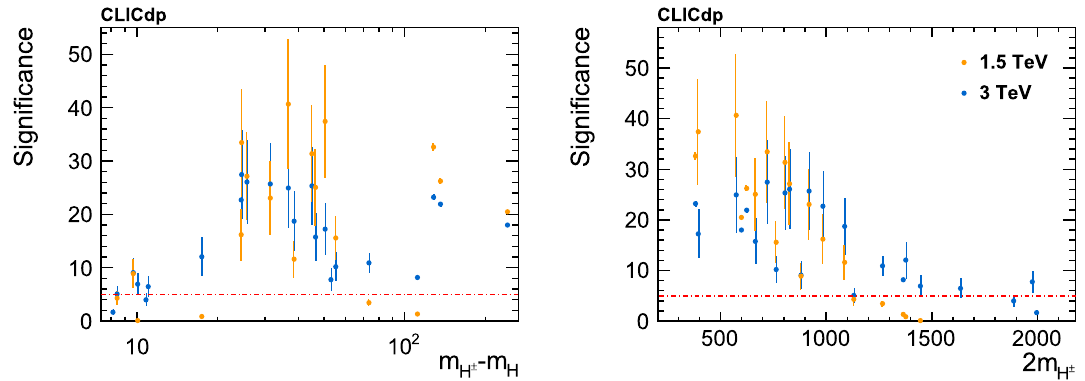
Fig. 7 Expected statistical significance of IDM charged scalar pair-production observation as a function of the IDM scalar mass difference, m H m H (left) and of the total mass of the produced IDM scalars, 2 m H (right). Results of the Delphes fast simulation study are presented ± − ± for CLIC running at 1.5TeV (orange circles) and 3TeV (blue points). Error bars indicate the systematic uncertainty, estimated from the observed difference between fast and full simulation results, see text for details. The red horizontal lines indicate the 5 σ threshold